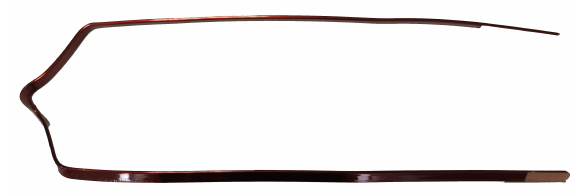
Figure 1. Elementary